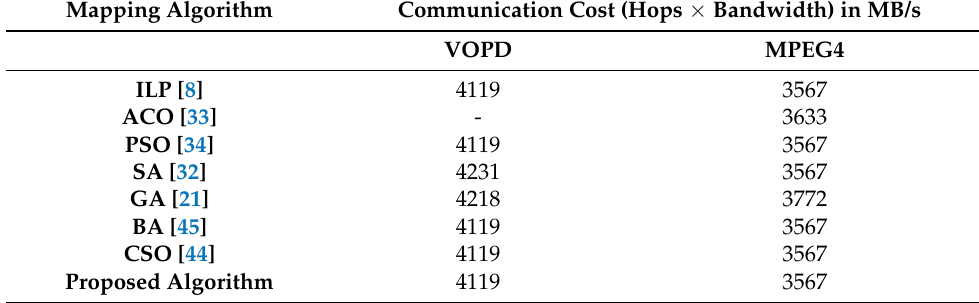
Table 4. Estimation of communication cost for 2D